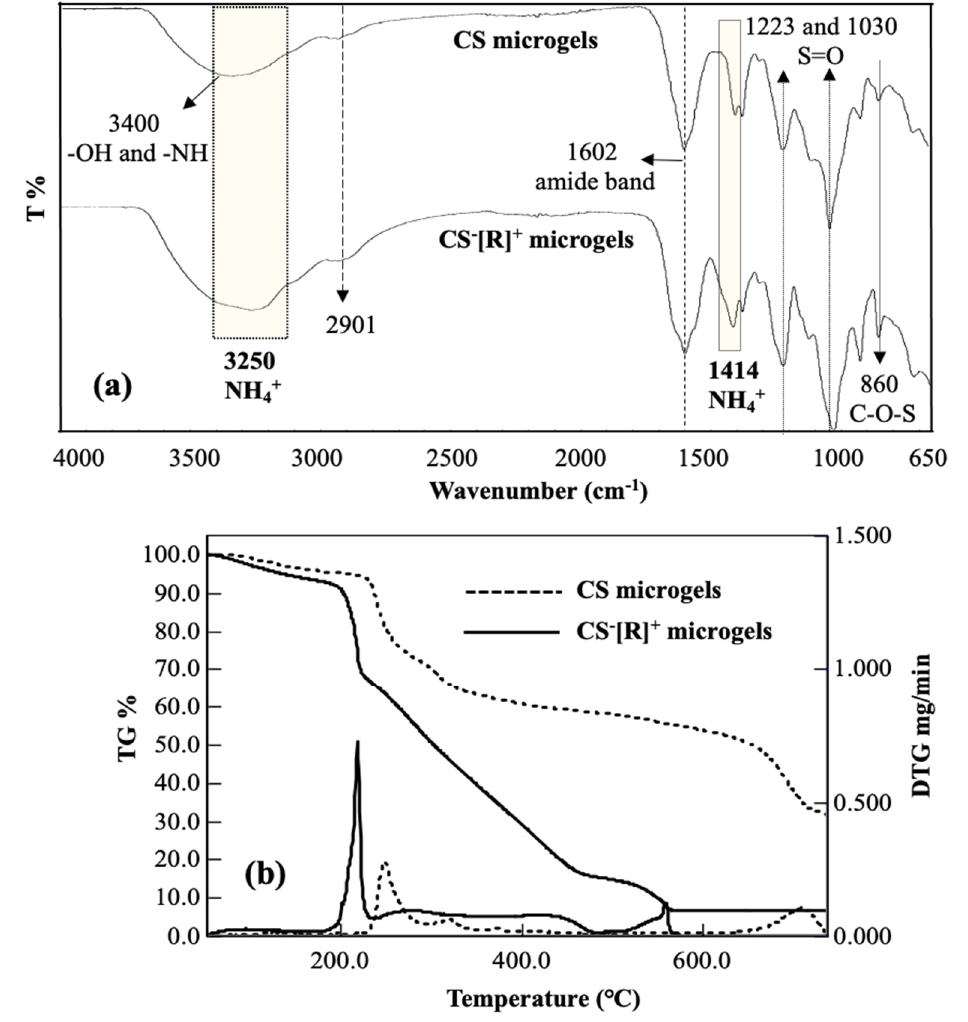
Figure 2. ( a ) FT-IR spectra and ( b ) thermogravimetric/differential thermogravimetric (TG/DTG) analysis curves of CS microgels and polyelectrolyte CS − [R] + microgels.